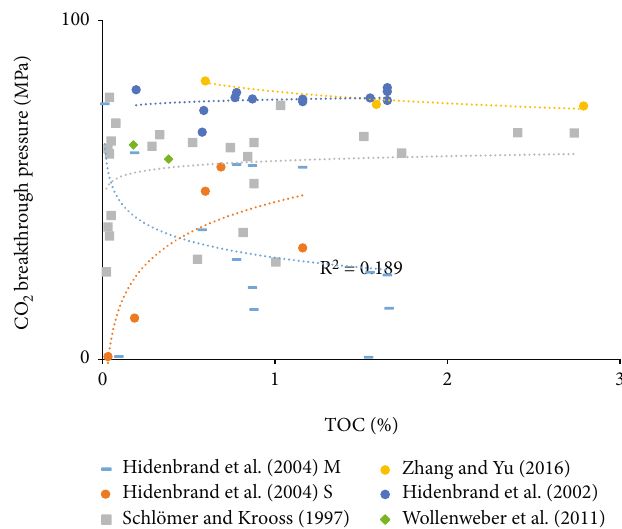
Figure 9: Relationship between TOC and breakthrough pressure of CO